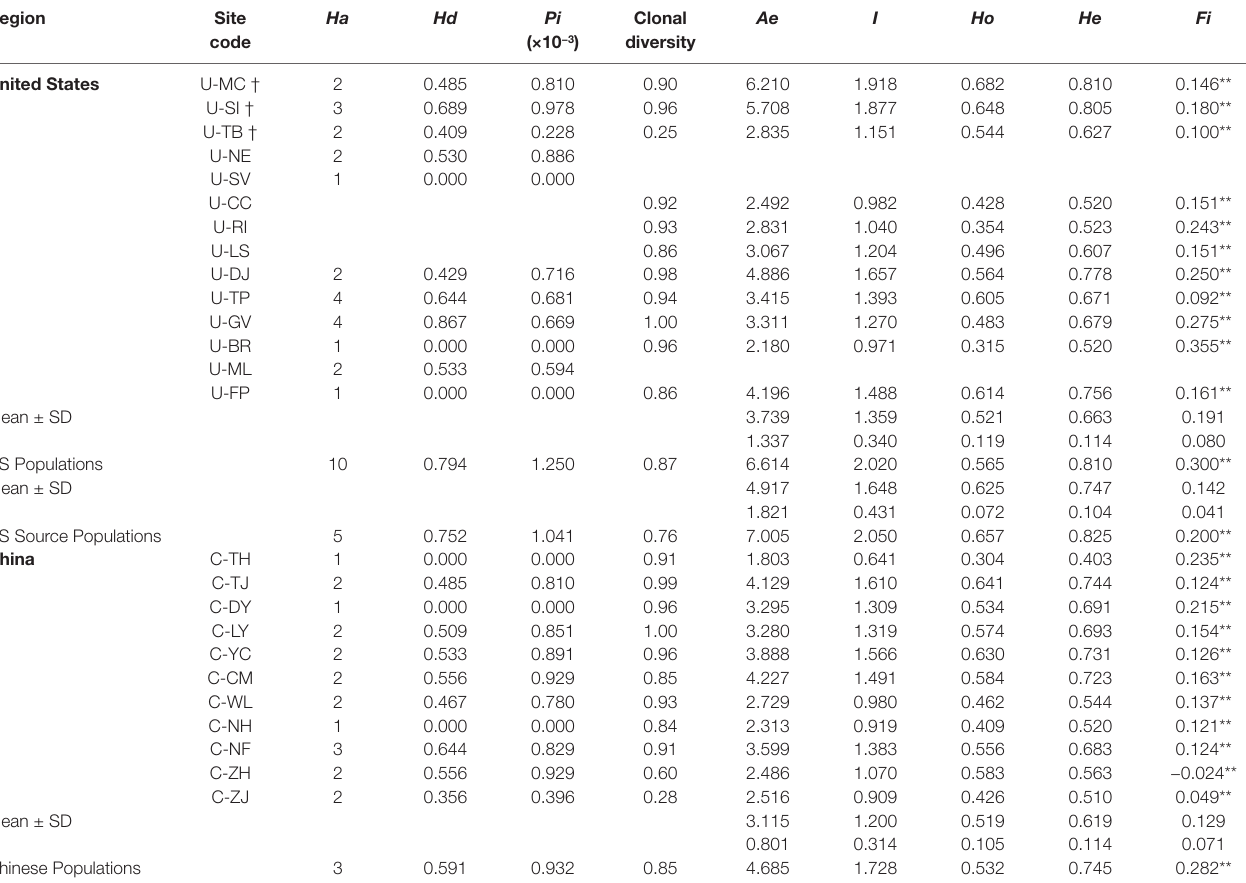
TaBle 1 | Measures of clonal and genetic diversity of native and invasive Spartina alterniflora . region Site